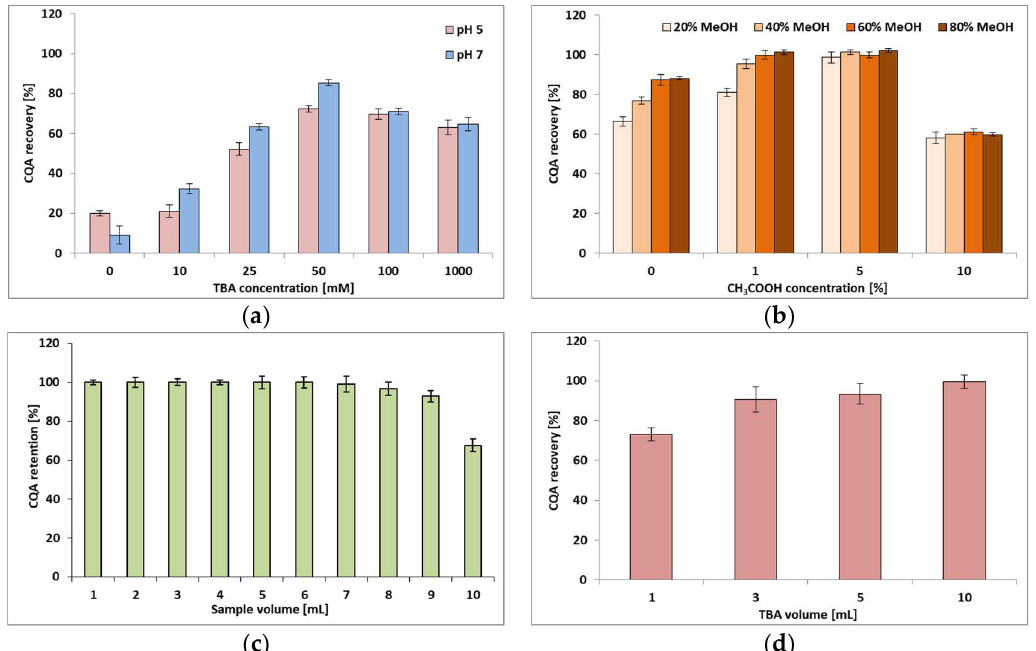
Figure 2. Effects of IP–SPE variables on the recovery(retention) rates of CQA: ( a ) TBA concentrations at two different pH values of chlorogenic acid solution; ( b ) methanol concentrations in the eluting mixture with or without the addition of 1, 5 or 10% v/v acetic acid solution; ( c ) volumes of the CQA solution with TBA that was passed through the sorbent during ion-pair formation in the CQA solution; and ( d ) volumes of TBA solution passed through the sorbent during ion-pair formation on the